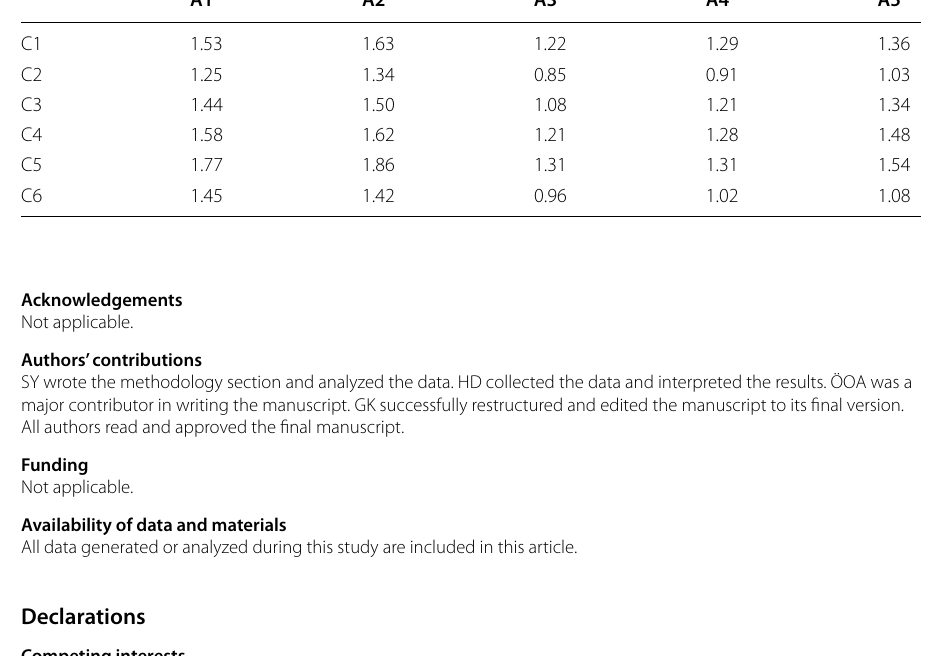
Table 15 Weighted decision matrix. Source : Author’s own table